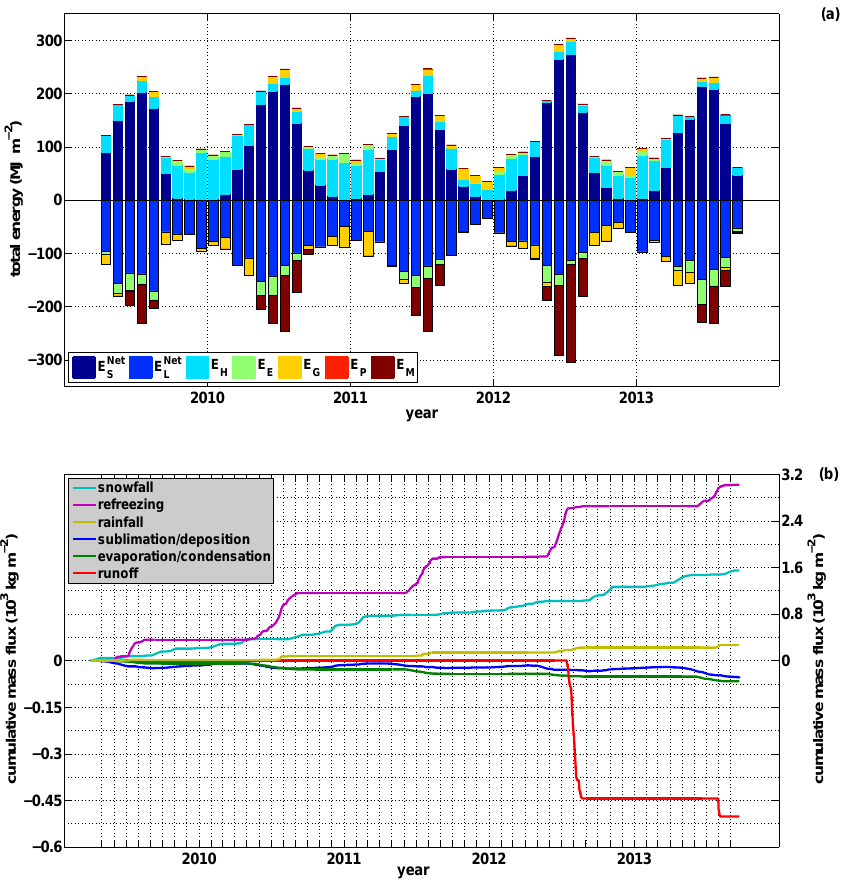
Figure 9. (a) Total energy per unit surface area. (b) Cumulative fluxes of all mass components. Note the different y scales in (b) .